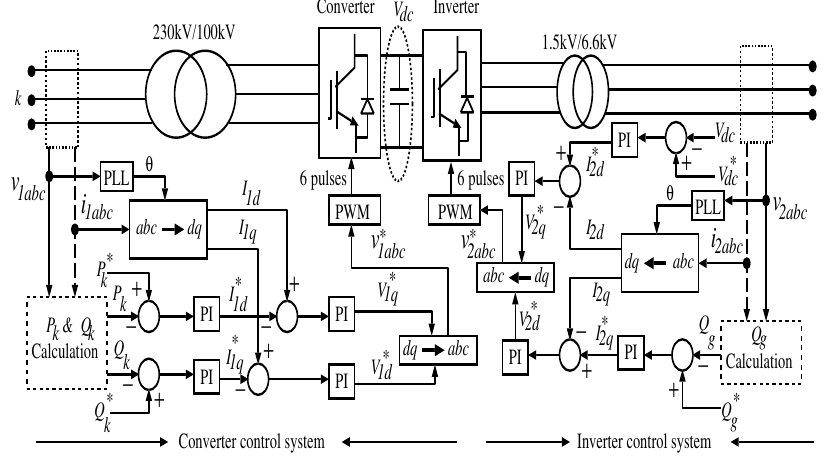
Figure 5. Power converter control system for the